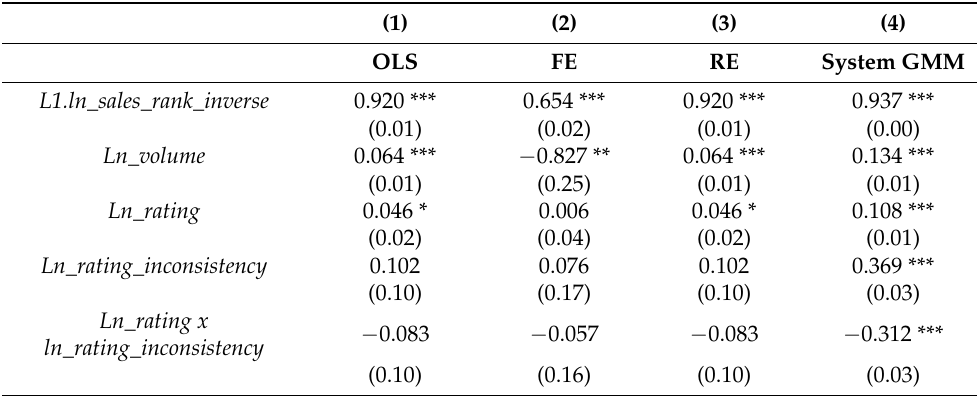
Table A3. Most recent visibility—all reviews, decreasing probability of being viewed (case v 3.1